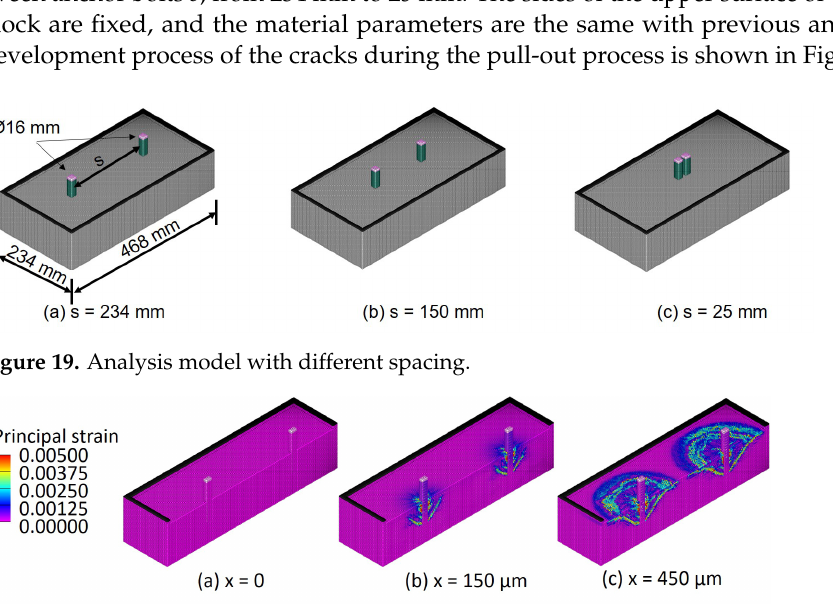
Figure 20. Crack development when the spacing s is 234